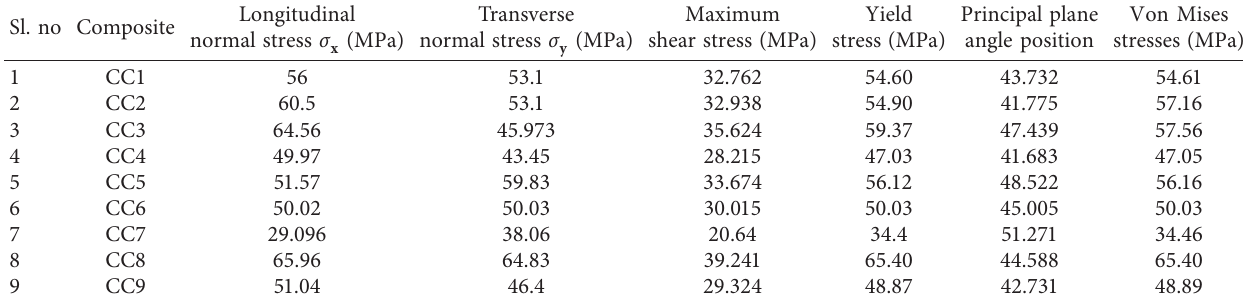
Table 11: Normal stresses, max shear stresses, and principal plane angle for coir composites.